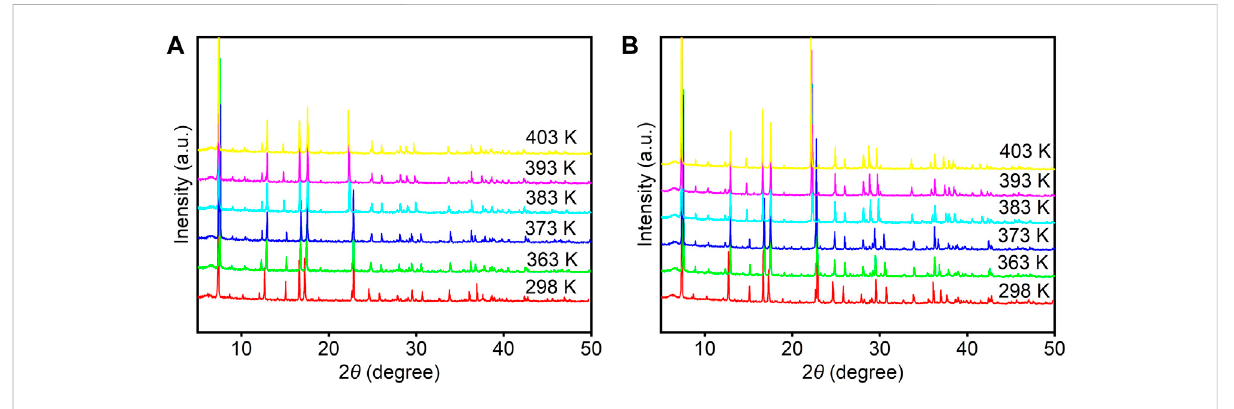
FIGURE 2 Variable temperature PXRD patterns of 1 (A) and 2 (B) .